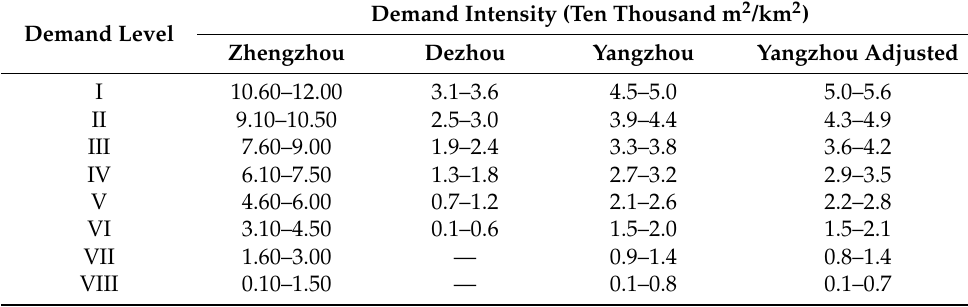
Table 9. Underground space demand